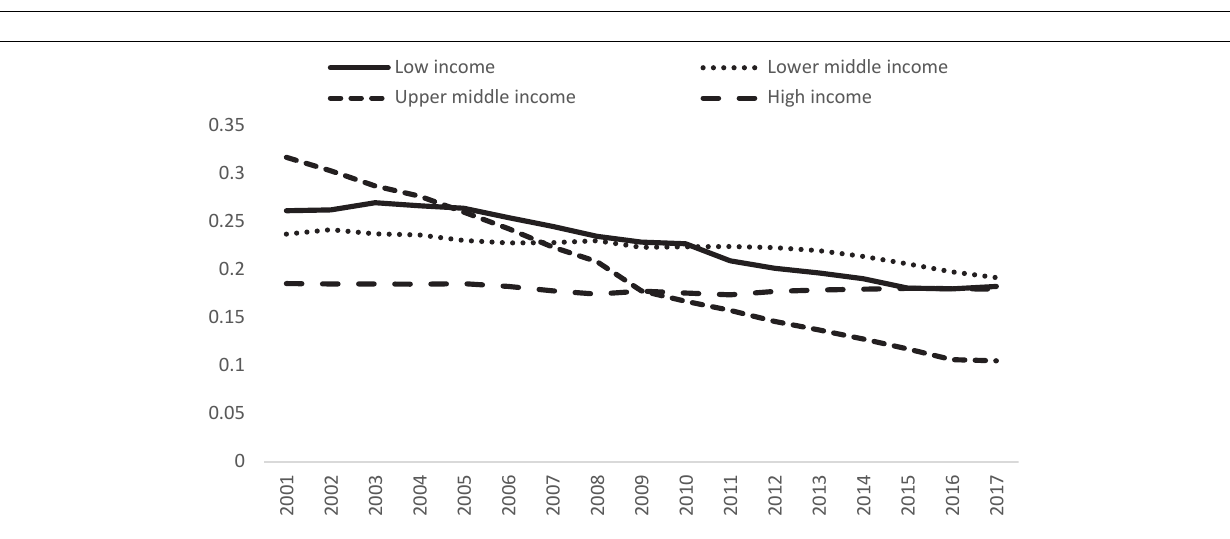
FIGURE 4 | Decomposition of inequality for the North and South, 2001 to 2017. Source: Authors’ calculation. (A) North and (B) South.